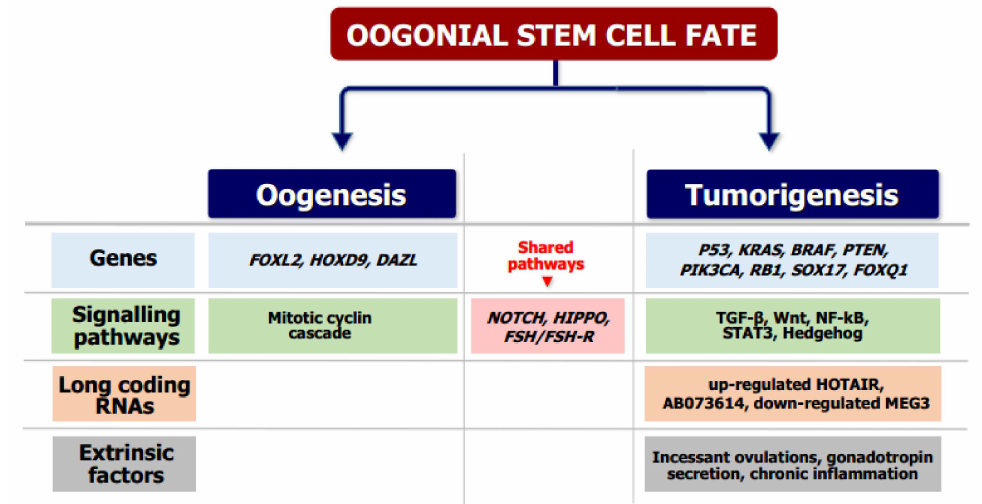
Figure 4. Molecular signals involved in OSC di ff erentiation. OSCs are able to undergo either neo-oogenesis or ovarian tumorigenesis depending on both di ff erent stimuli and activated pathways that in some cases are also shared. The molecular signals shown include well-established mechanisms and putative pathways, as reported in the literature